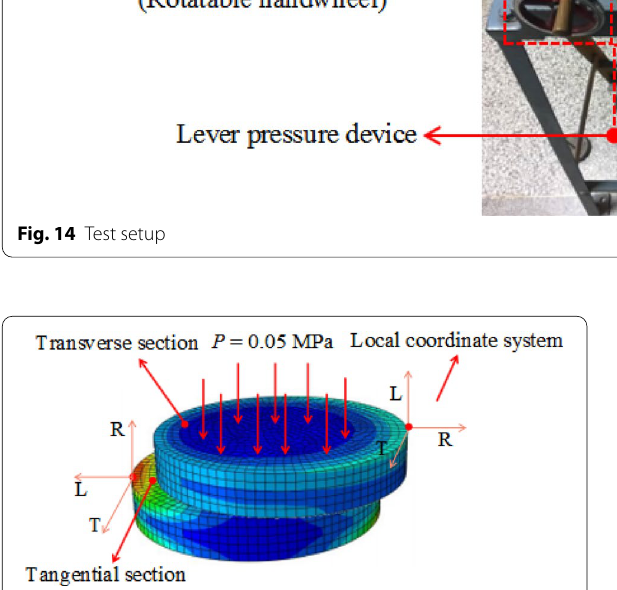
Fig. 15 FEA model of transverse–tangential contact surfaces of wood